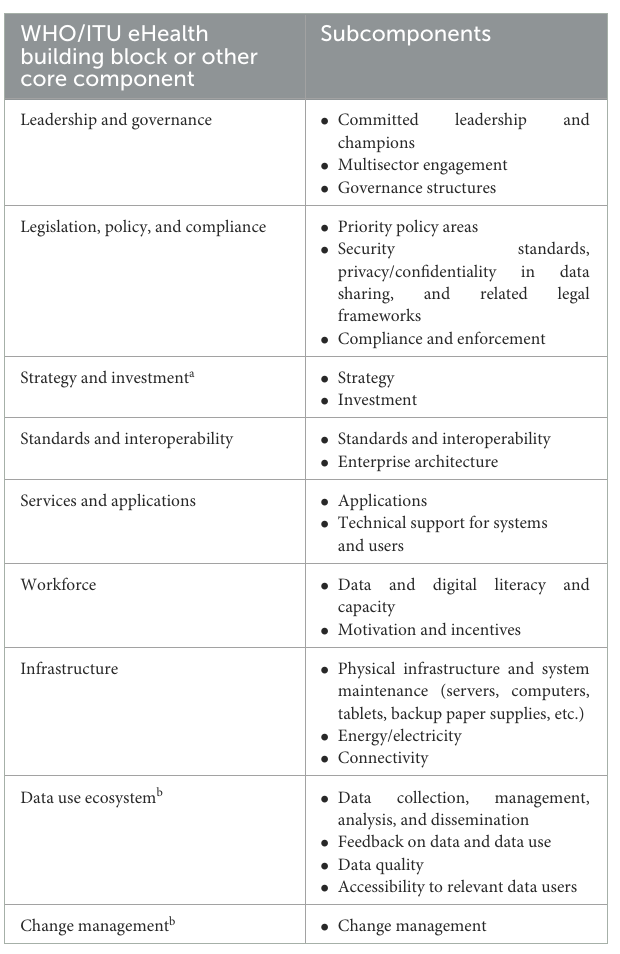
TABLE 1 Framework for digital transformation for data use.